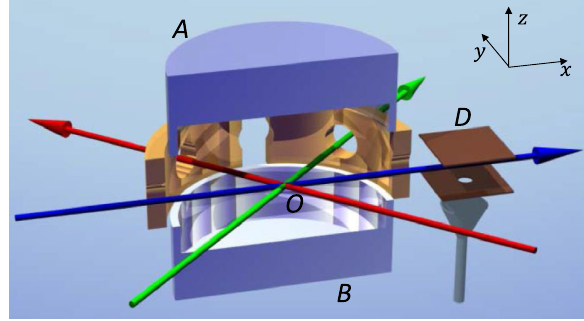
FIG. 2. Scheme of the experiment. A rubidium thermal beam (dark blue arrow), effusing from an oven, crosses a structure made of two plane-parallel electrodes A and B (blue) creating the vertical directing electric field F . They are surrounded by four ring electrodes (yellow, two of them are not represented). At the center O of the structure, the atoms interact with three laser beams (780 and 776 nm, σ þ polarized, red arrow; 1258 nm, π polarized, green arrow) that cross at 90° in the horizontal plane. At the end of the sequence, the atoms are detected in the state-selective field- ionization detector D